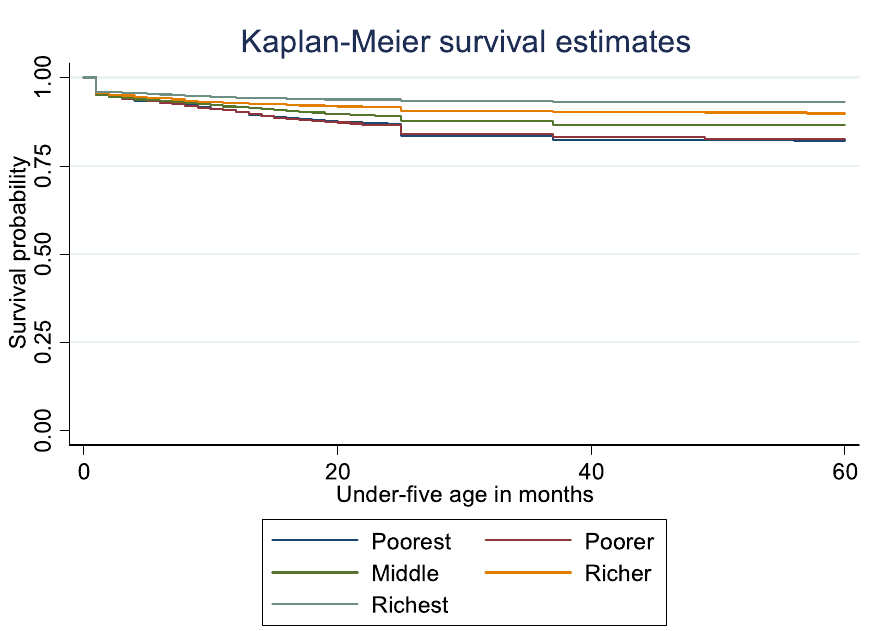
Figure 3. Plot of the Kaplan–Meier survival estimates of under-five mortality by household wealth index quintiles in Nigeria,